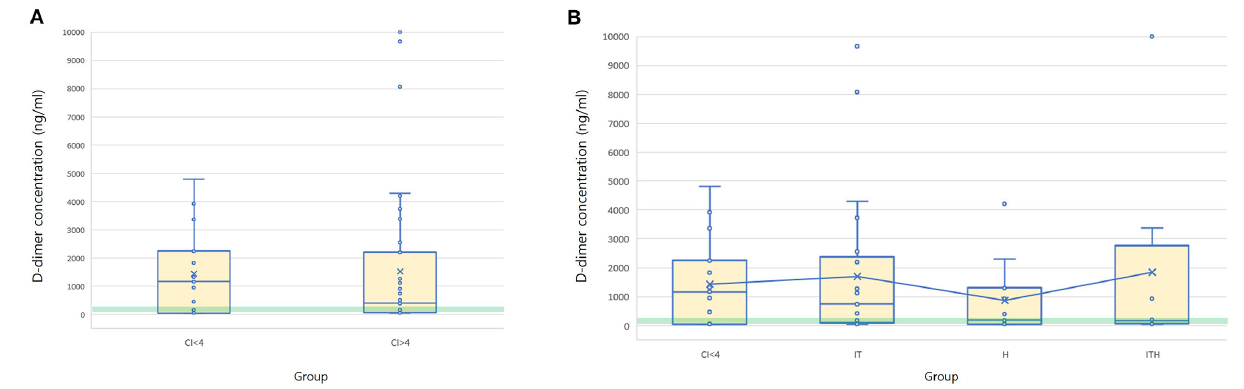
FIGURE 1 | Box and whisker diagrams depicting D-dimer concentration of 44 dogs with CI > 4 and 15 dogs with CI < 4. Median and mean values of D-dimer concentration is compared between the groups of CI > 4 and CI < 4 (A) , and CI < 4, IT, H, and ITH (B) . The central box represents the values from the lower to upper quartiles and the middle line is the median. The horizontal lines represent minimum to maximum values. X indicate the mean value of the D-dimer concentration in each group. Green semitransparent box represents the normal reference interval of D-dimer concentration (50–250ng/ml). There is no significant difference of the mean D-dimer concentration between the groups. IT, inflammatory/tumor; H, hemodynamic compromise; ITH, inflammatory/tumor and hemodynamic compromise; CI, coagulation index.